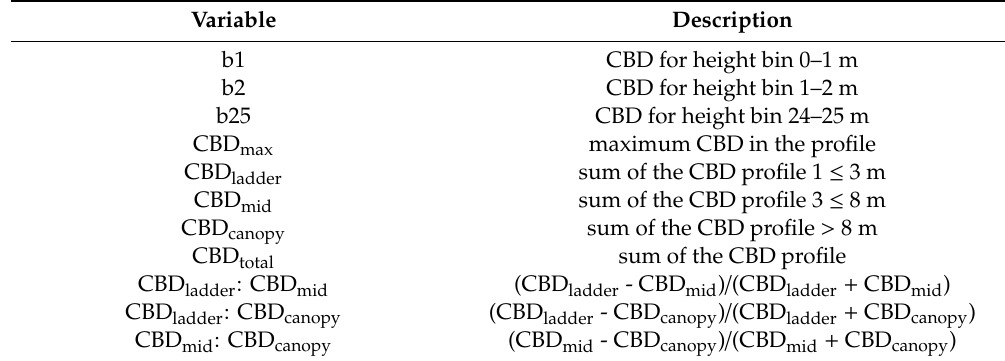
Table 1. ALS-derived variables of fuel loading